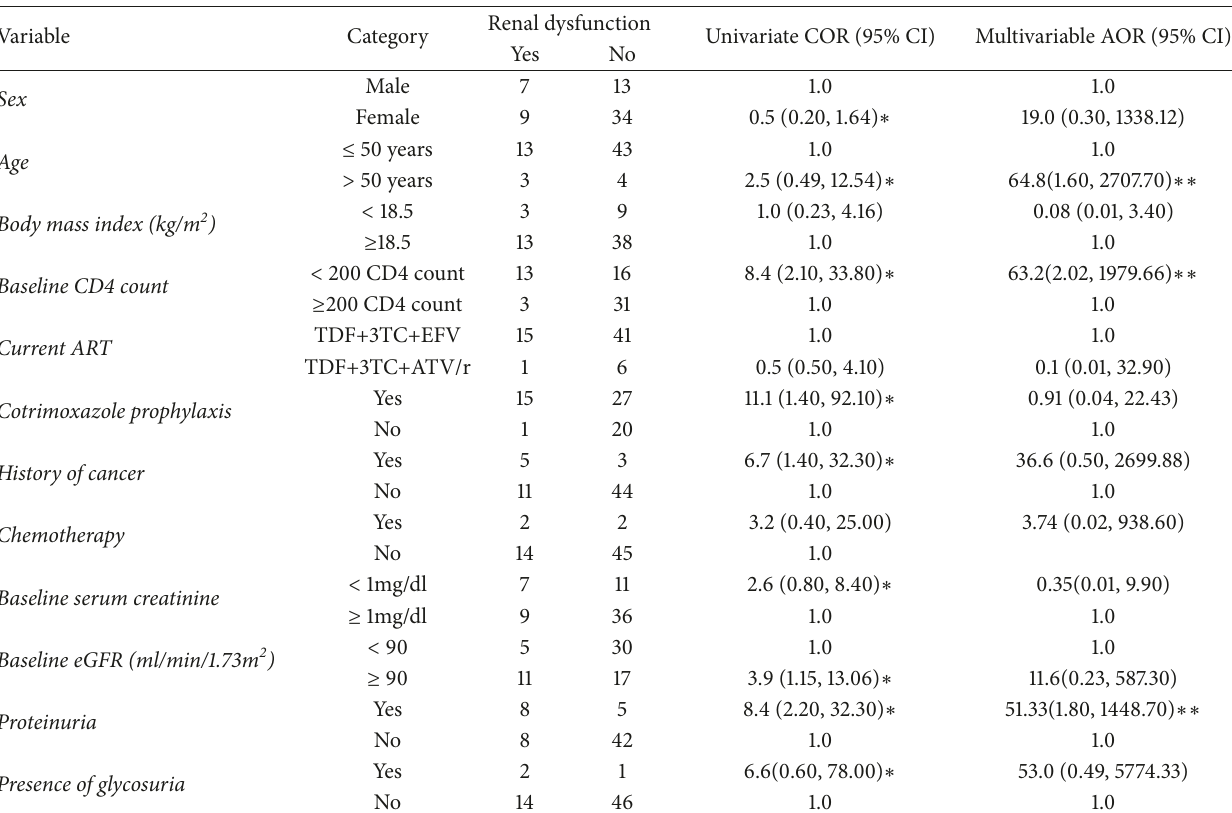
Table 5: Factors associated with greater than 25% fall in eGFR during the study period by univariate and multivariable logistic regression in TASH, October 2017 [n = 63].